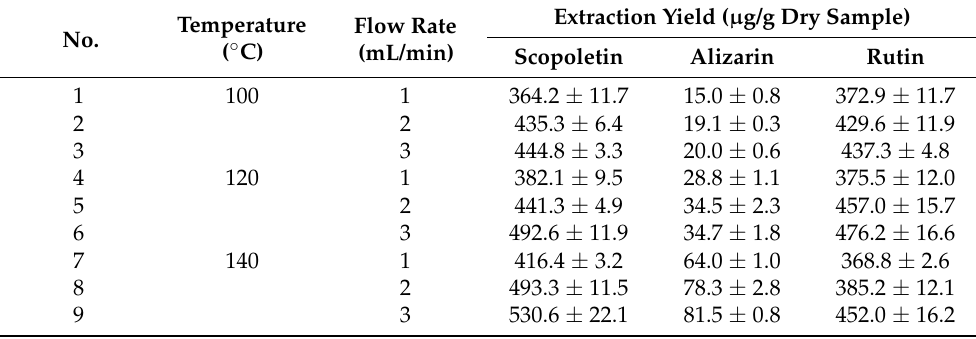
Table 1. The phenolic compound yields from noni fruits by subcritical water extraction at different temperatures and flow